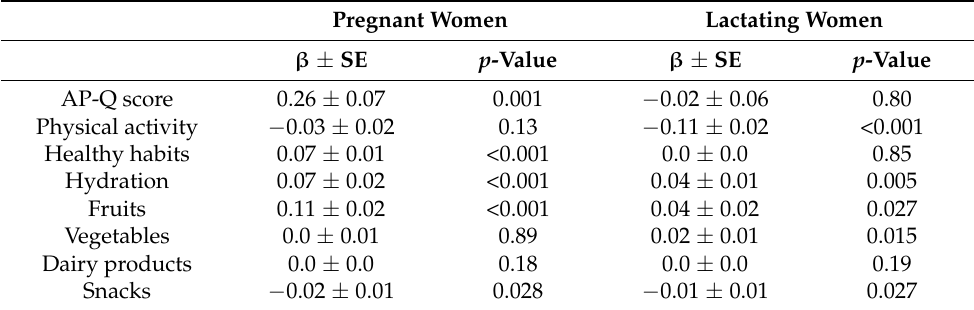
Table 4. Regression models between groups, categories, and the AP-Q